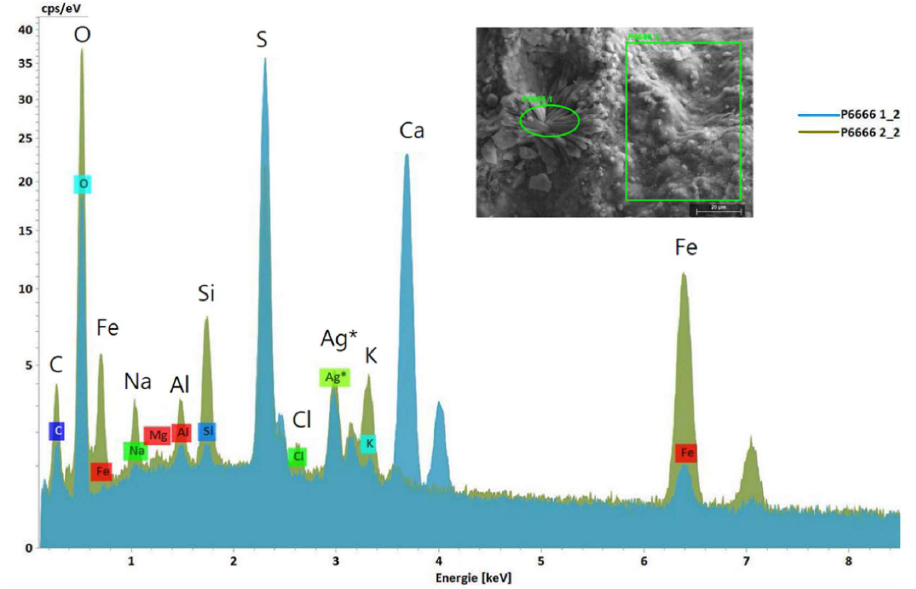
Figure 9. SEM image with selected areas from Stefføya sample for SEM-EDS analyses (inset) and the corresponding overlayered EDS spectra acquired. Jarosite, natrojarosite, gypsum, aluminosilicates and silicates are implied from the elements detected. The oval green area resulted in the light blue spectrum (gypsum) whereas the rectangular area selected gave the olive green one (jarosite, silicates and aluminosilicates). The silver detected is from the coating used to make the sample electrically conductive in the analysis. Larger symbols are used for visibility in addition to the ones generated by the EDS software.